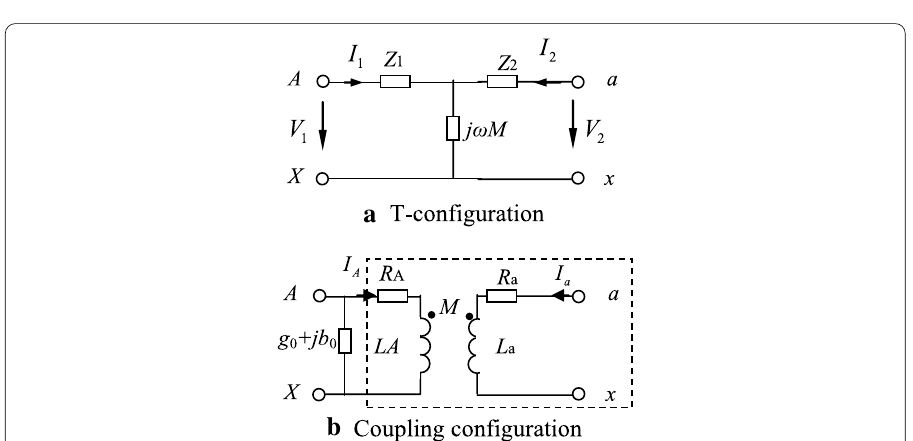
Fig. 2 Single-phase equivalent circuits of the double-winding transformer; a is the model of T-configuration, Z 1 and Z 2 are connected together, and The mutual impedance is connected between them. They form a T-shaped connection. b Model of Coupling configuration, which mutual impedance is generated by